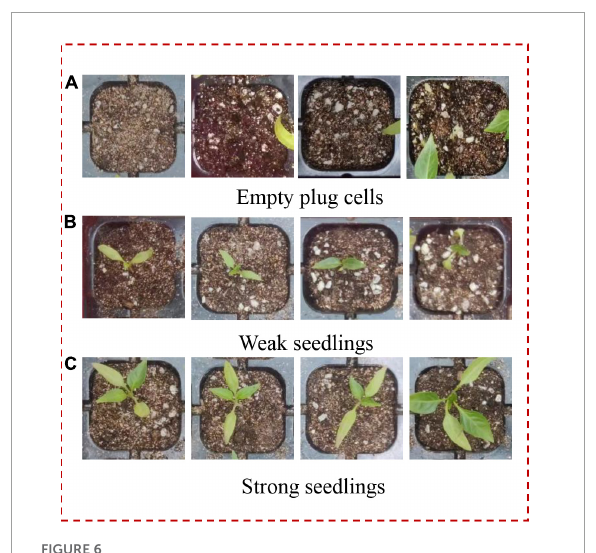
FIGURE6 Plug seedlings of different qualities. (A) Empty plug cells. (B) Weak seedlings. (C) Strong seedlings.